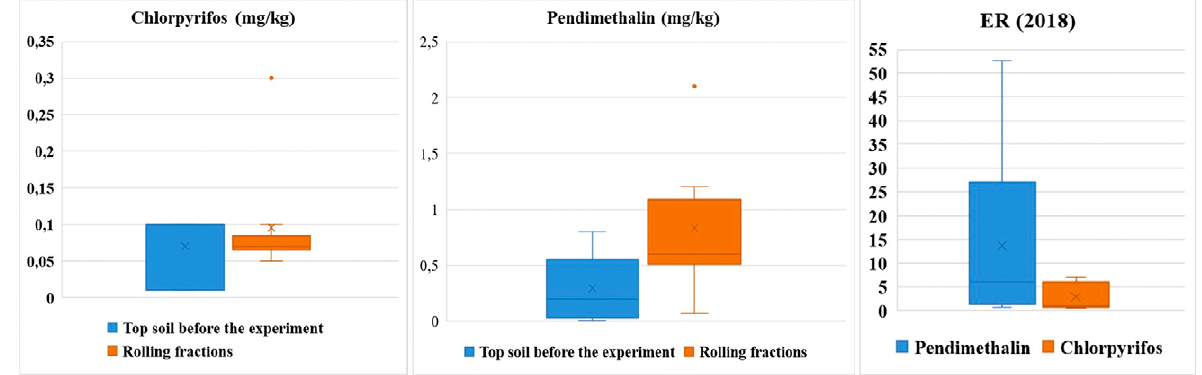
Figure 9. Results of concentration and enrichment of chlorpyrifos and pendimethalin in